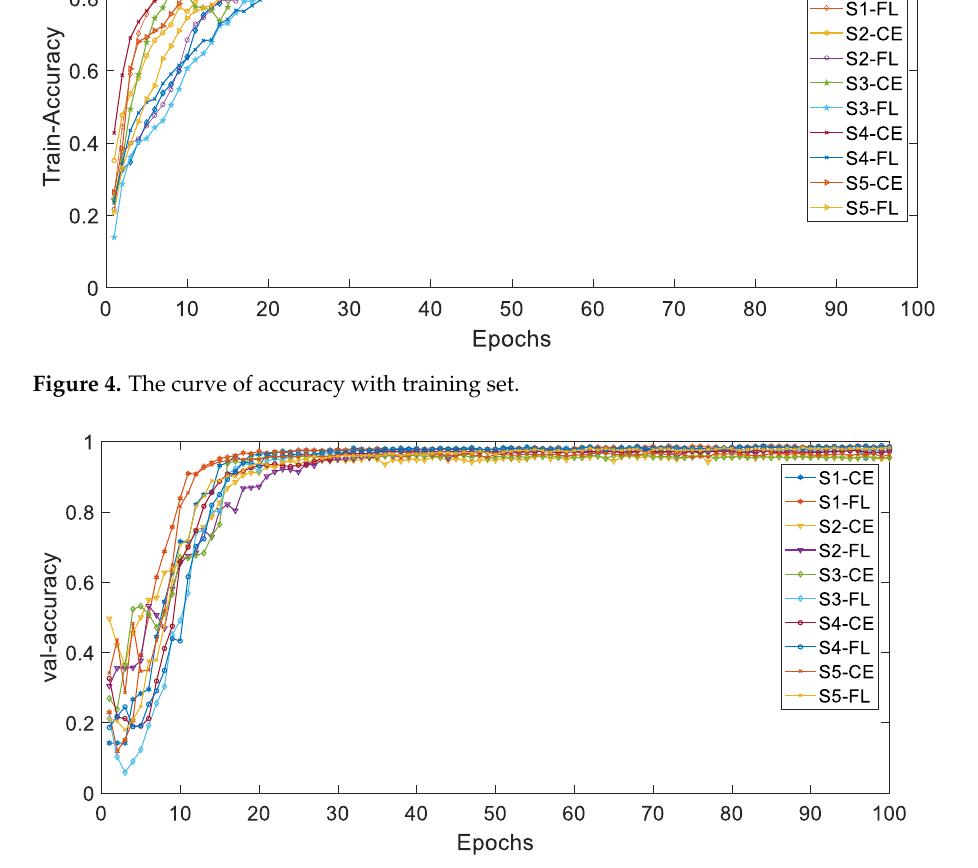
Table 7. Comparison of HAR-CE and HAR-FL.